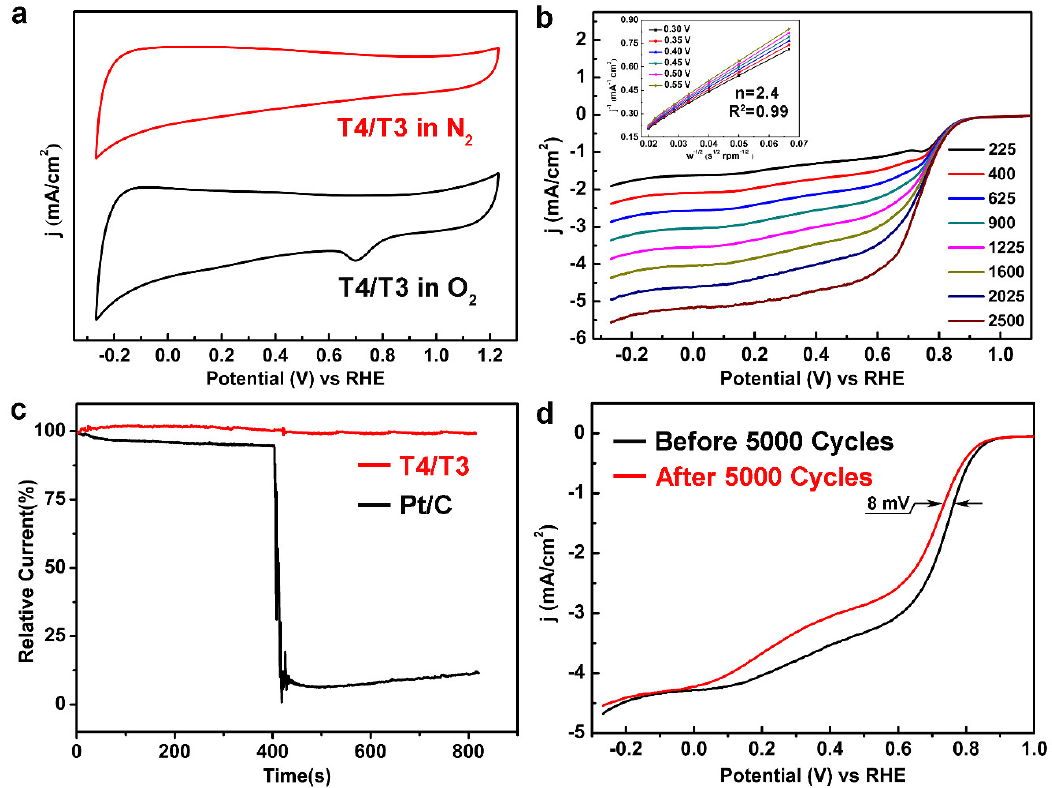
Figure 4. The comparison of the CV curves ( a ) in N 2 and O 2 -saturated 0.1 M KOH solution confirmed the ORR catalytic activity of T4/T3 dual-phase catalysts. The LSV curves ( b ) at different rotation rates (225, 400, 625, 900, 1225, 1600, 2025, and 2500 rpm) illustrate the initial and half-wave potential of 0.90 V and 0.75 V, respectively. The inset figure shows the Koutecky-Levich plots (j −1 vs. w −1/2 ) at different potentials. The i-t chronoamperometric curves ( c ) of T4/T3 and Pt/C catalysts at 0.7 V (vs RHE) in O 2 -saturated 0.1 M KOH solution suggest the excellent methanol resistance of T4/T3 dual-phase catalysts. The turning point represents 6 M methanol added into the solution (at 400 s). Polarization curves of T4/T3 at 0.7 V (vs RHE) in O 2 -saturated 0.1 M KOH solution at a rotating rate of 1600 rpm before and after 5000 cycles ( d ) suggest excellent stability of such catalysts.